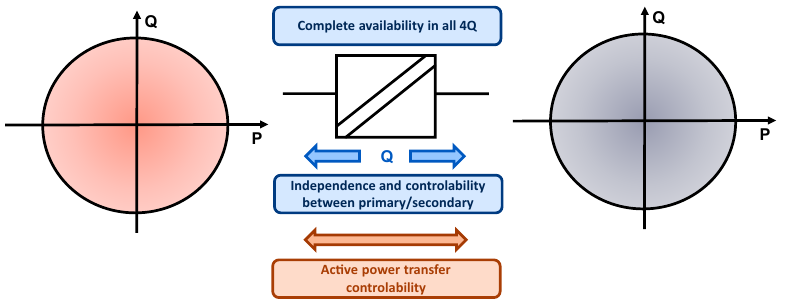
Figure 5. Reactive power injection feature of a SST device. Reactive power can be fixed independently at each side with a four-quadrant capability